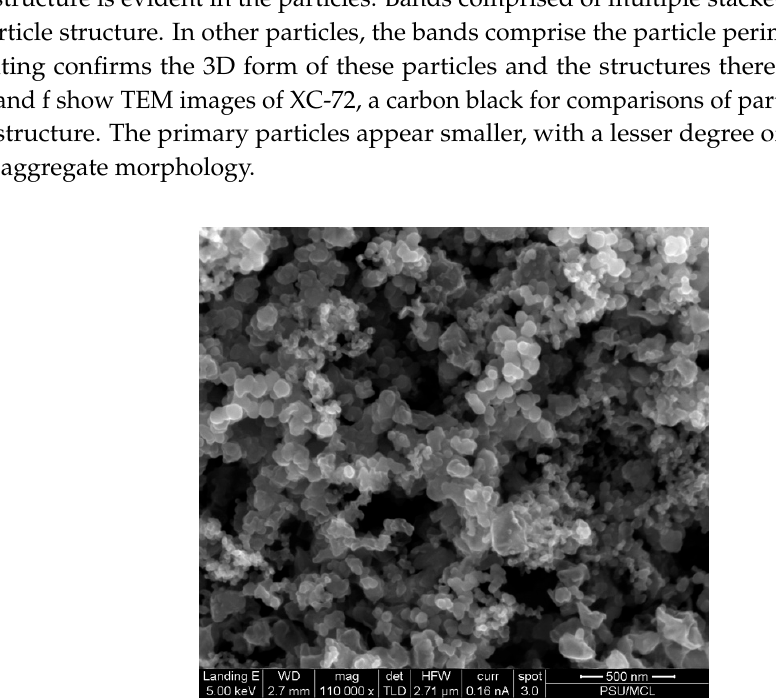
Figure 2. SEM image of the microwave-produced carbon showing the particle and aggregate